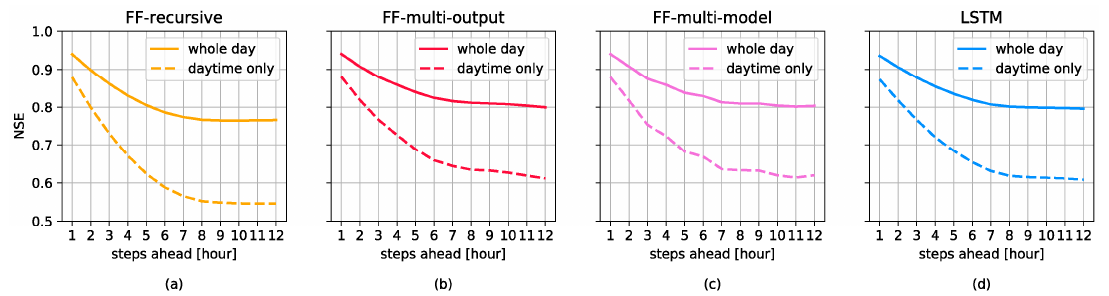
Figure 7. NSE of hourly average solar irradiance at Como obtained with recursive FF ( a ), multi-output FF ( b ), multi-model FF ( c ), and LSTM ( d ). Solid line represents the performance in the whole day, dashed line in daytime only. Values refer to the test year